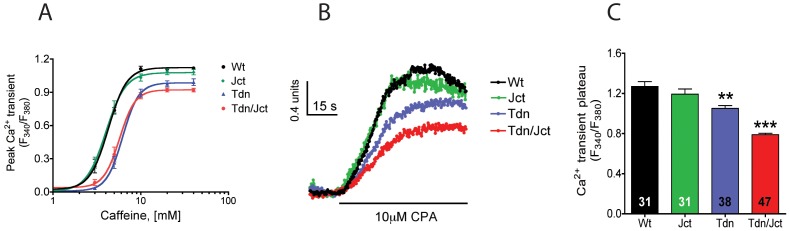
Effect of Tdn and Jct ablation on SR Ca2+ content of cultured myotubes.A) Average peak fluorescent amplitude of caffeine-induced Ca2+ transients of Fura-4F loaded myotubes from WT (black, n = 59 cells), Tdn-null (blue, n = 52 cells), Jct-null (green, n = 60 cells) and Tdn-/Jct null (red, n = 59 cells) mice. B) Representative traces of CPA-induced Ca2+ transients of WT (black), Jct-null (green), Tdn-null (blue) and Tdn/Jct-null (red) myotubes loaded with Fura-2 used to estimate SR Ca2+ content. C) Comparison of average peak Ca2+ transient amplitude induced by 10 µM CPA. Numbers in the bars indicate the number of cells analyzed per condition. Data presented as mean ± SEM. **p<0.01, ***p<0.001 (ANOVA, One-way analysis of variance, Tukey's multiple comparison test).